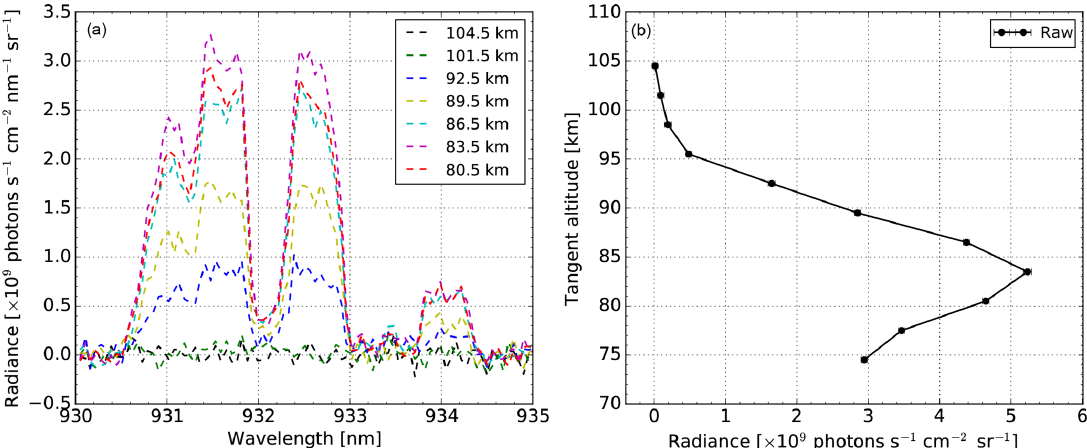
Figure 4. (a) GOMOS monthly zonal mean spectra of OH(8–4) emissions at tangent altitudes as given in the figure legend for October 2003 at 0–10 ◦ S and at a local time of 22:00–00:00LT. (b) The spectrally integrated radiance over 930–935nm versus tangent altitude for the same conditions. The error bars indicate the measurement noise for integrated radiance (see